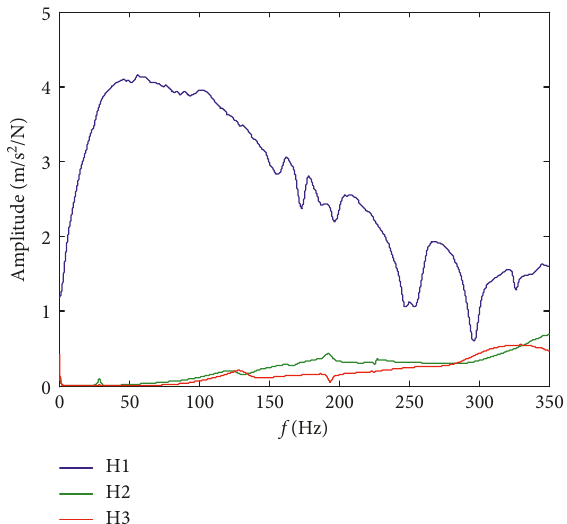
Figure 11: Measured transfer functions of the cylinder.